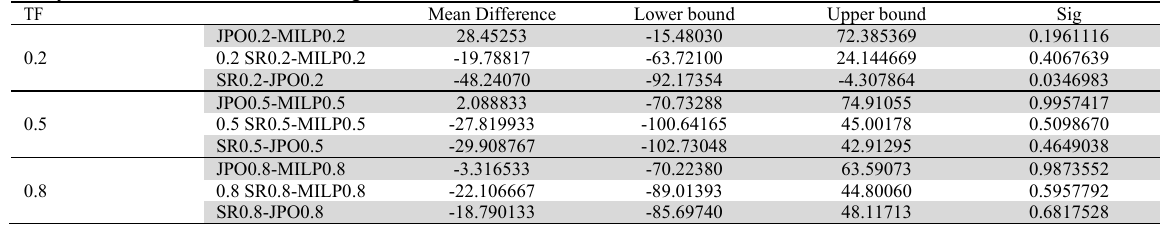
Tukey HSD 95% confidence of average RDI values for TF TF Mean Difference